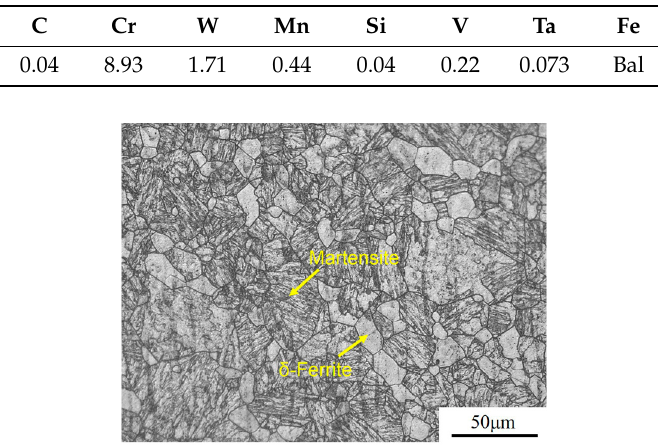
Figure 1. Optical micrographs showing the microstructure of the original reduced activation ferritic/martensitic (RAFM) steel after casting and hot processing.